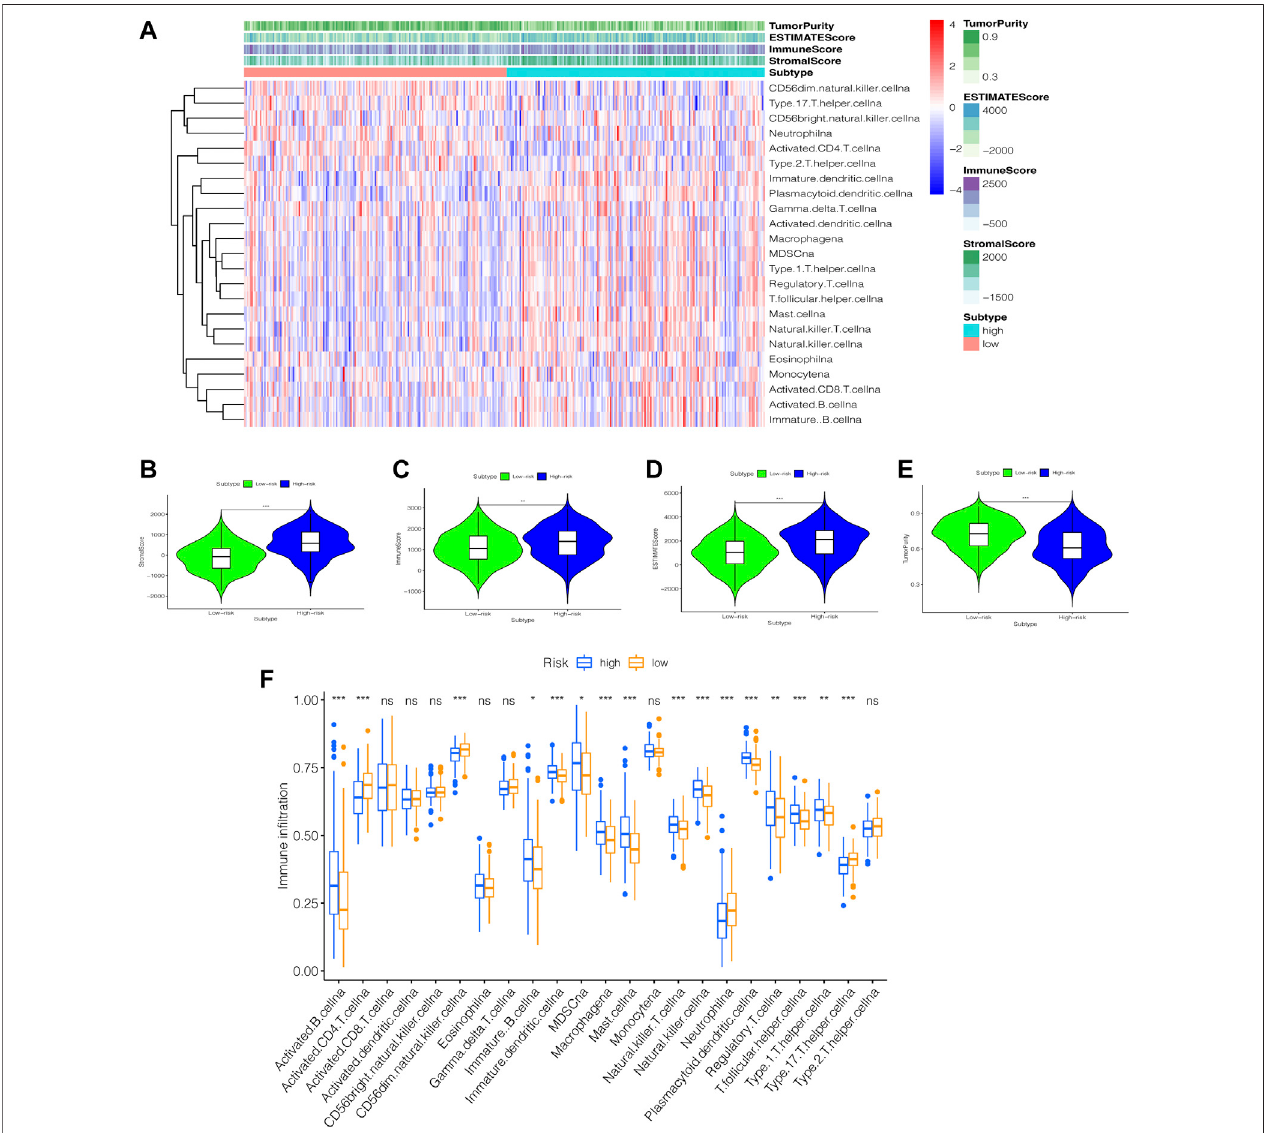
FIGURE10| Anexaminationoftheimmunestatusofthetumormicroenvironment. (A) heatmap.Thesamplenameisrepresentedbytheabscissa,andtheimmune gene set is represented by the ordinate. The upper section contains tumor microenvironment scores, in which Stromal Score, Immune Score, and ESTIMATE Score decrease as risk low, implying that the content of corresponding cells decreases. Tumor purity is diametrically opposed to them. (B – E) Violin Plot. The statistical relationshipbetweenthedegreeofriskandeachtumormicroenvironmentalparameterisinvestigated. (F) boxplot.Immunecellsubsetdifferencesinhigh-andlow- risk groups. *, p < 0.05. **, p < 0.01. ***, p < 0.001. ns, p > 0.05.